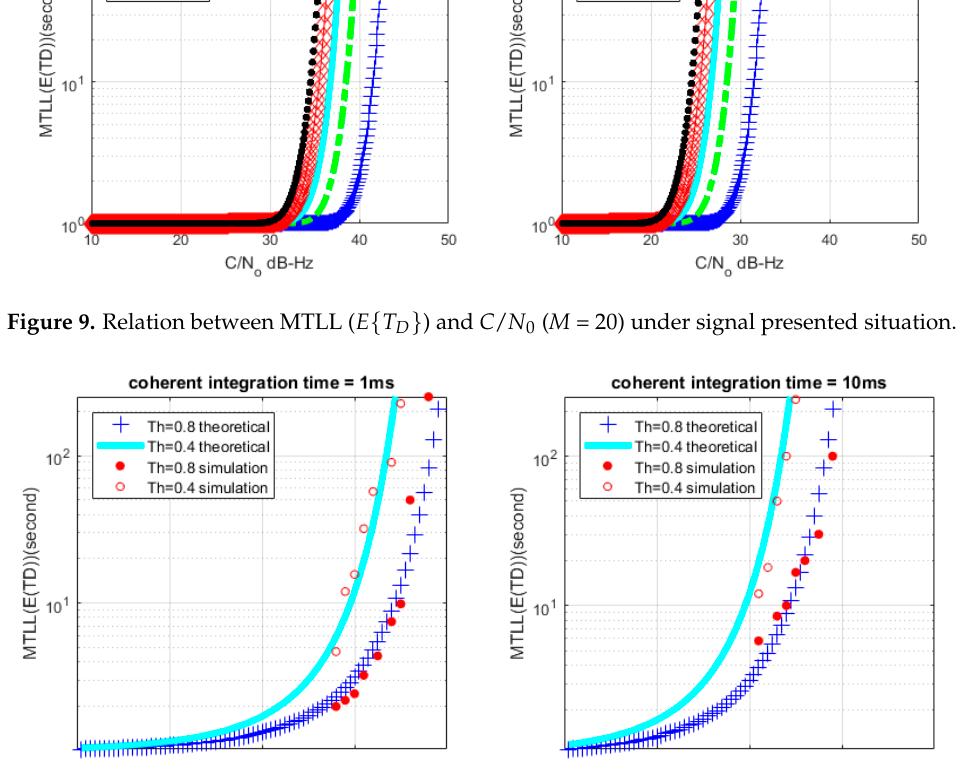
Figure 10. MTLL ( E T ) of theoretical and simulation C / N 0 ( M = 1).